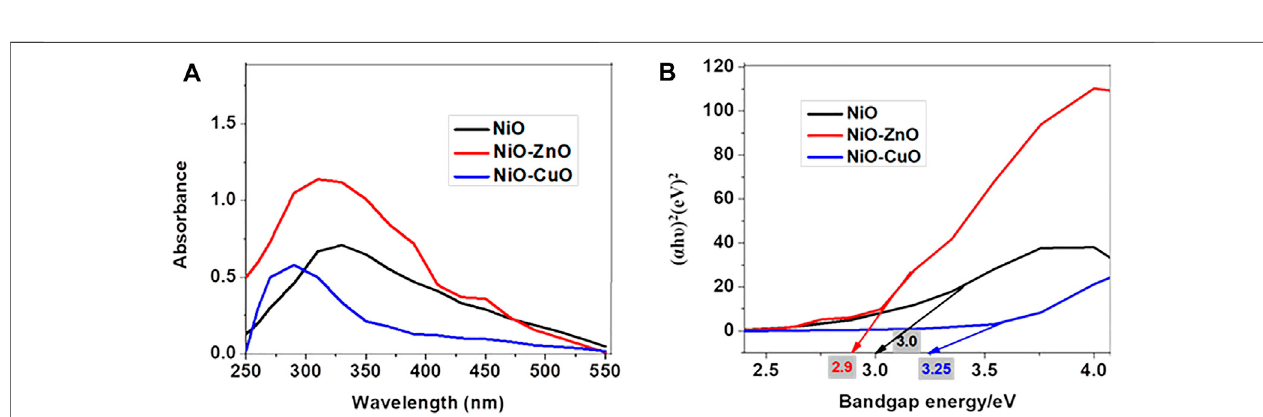
FIGURE 4 | (A) UV – Visible absorption spectra and (B) Tauc plot of NiO, NiO-ZnO, and NiO-CuO.